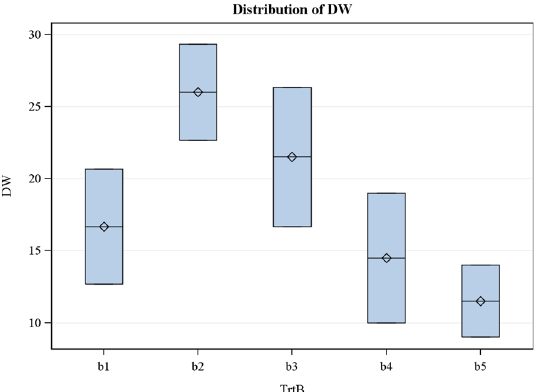
Figure 1. Effects of limestone levels on the dry weight of